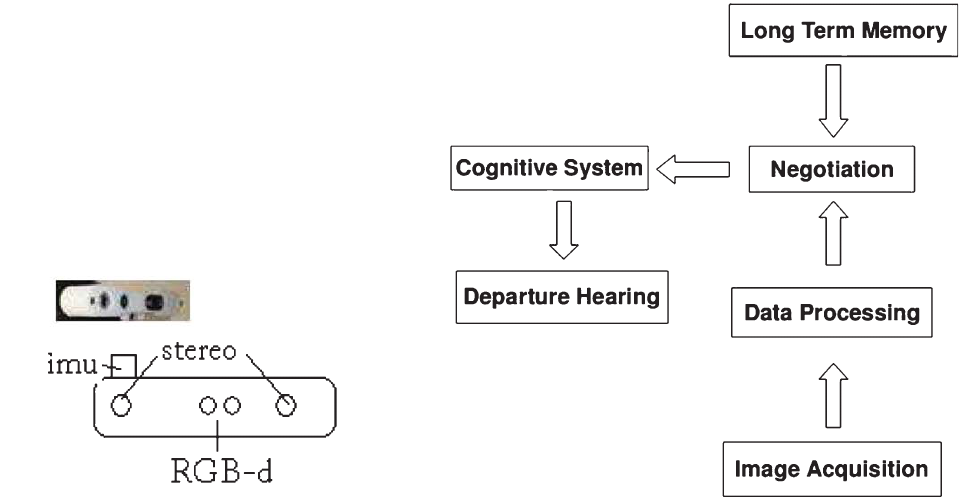
Fig. 1. (left) the guidance system; (right) abstraction of the function of the intelligent guidance system.